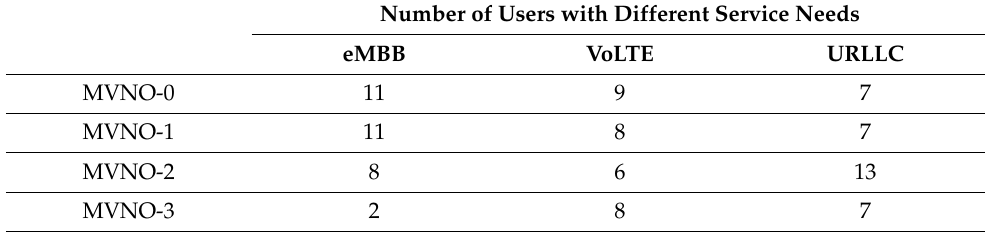
Table 3. Number of users with different service requirements connected by MVNO.